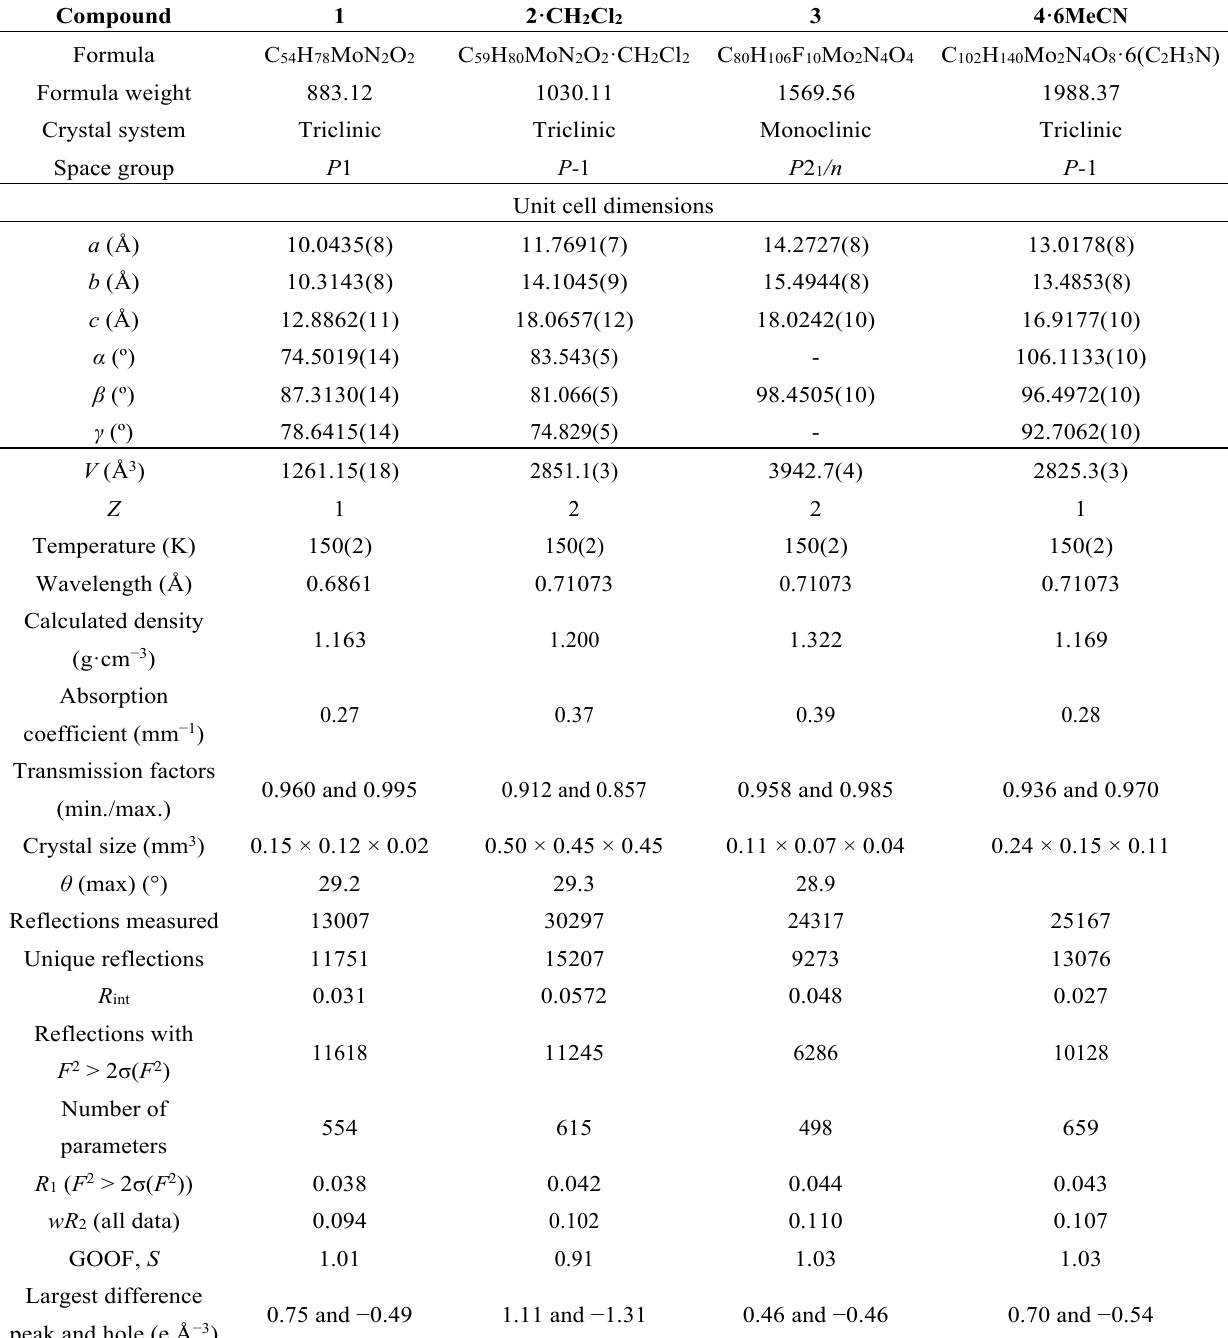
Table 1. Crystallographic data for the complexes 1 , 2 ·CH 2 Cl 2 , 3 , 4 ·6MeCN, 6 ·2C 6 H 14 , 7· 6MeCN and 8